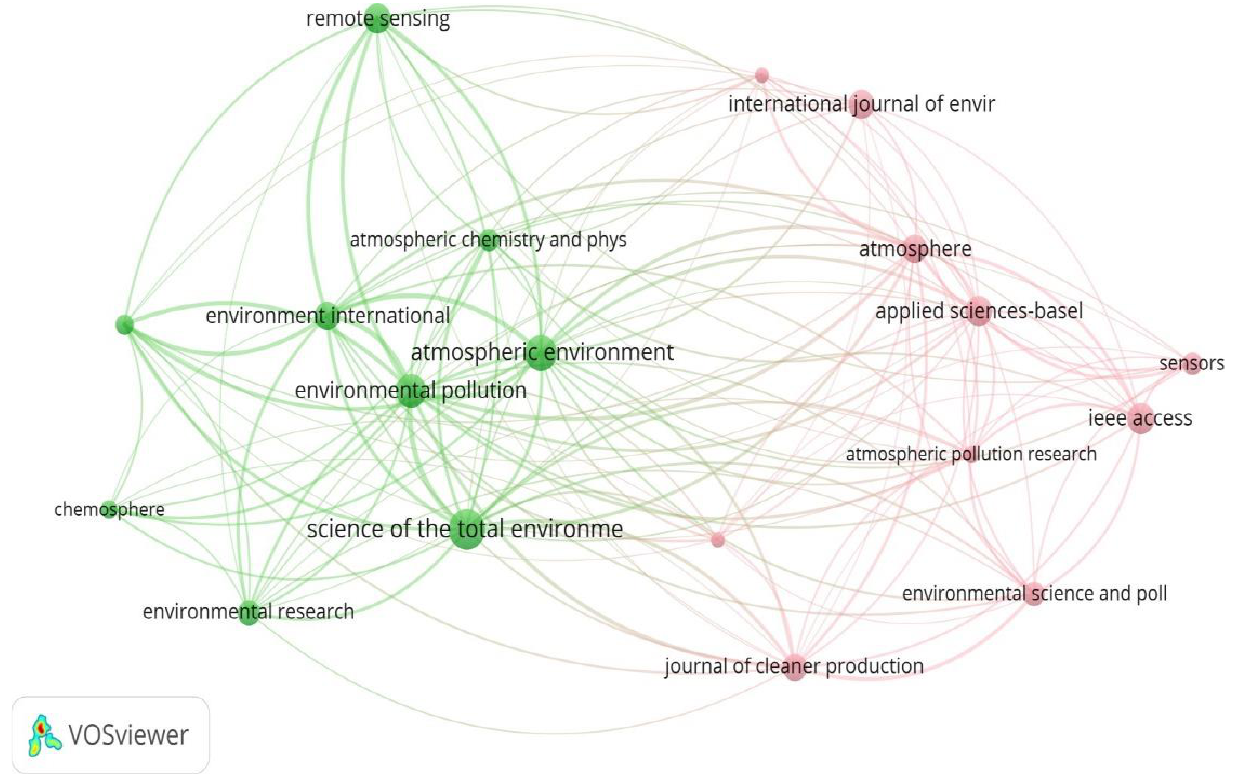
Figure 9. Map of citation analysis of Main Journals.